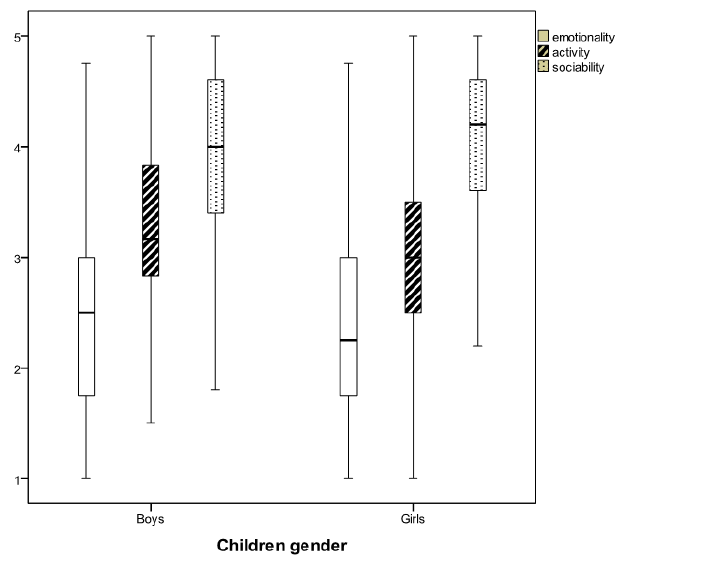
Figure 3 . Boxplot of EAS-dimensions according to children’s gender